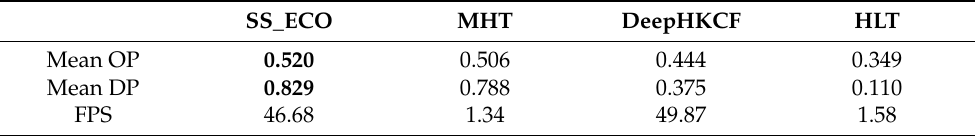
Table 6. Mean OP, DP metric (in %) and fps of SSCF and hyperspectral